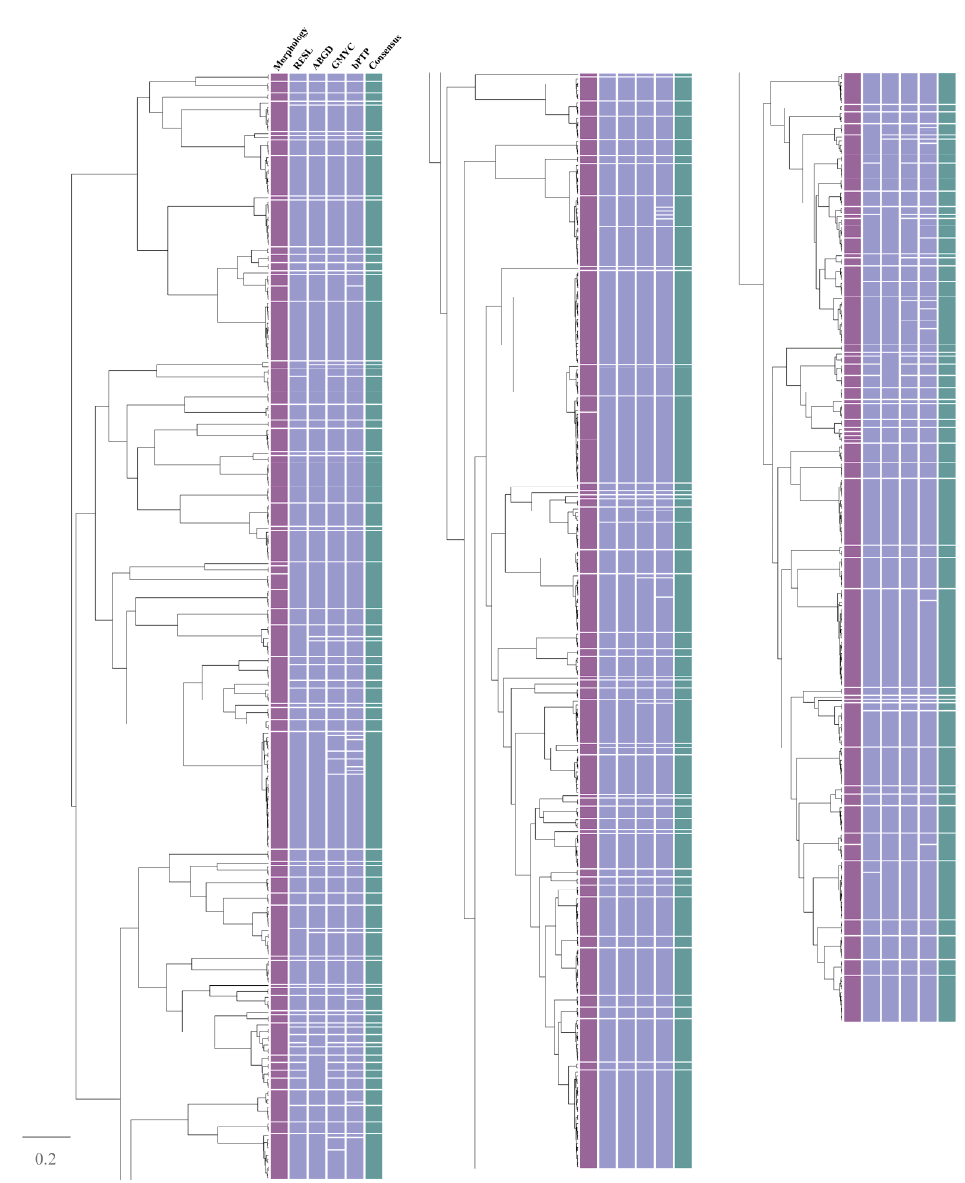
Figure 3. Bayesian inference tree of the studied 159 fish species of Guizhou. Color bars indicate six delimitation results, including morphospecies, RESL, ABGD, GMYC, bPTP, and consensus. The scale bar indicates the number of substitutions per site.